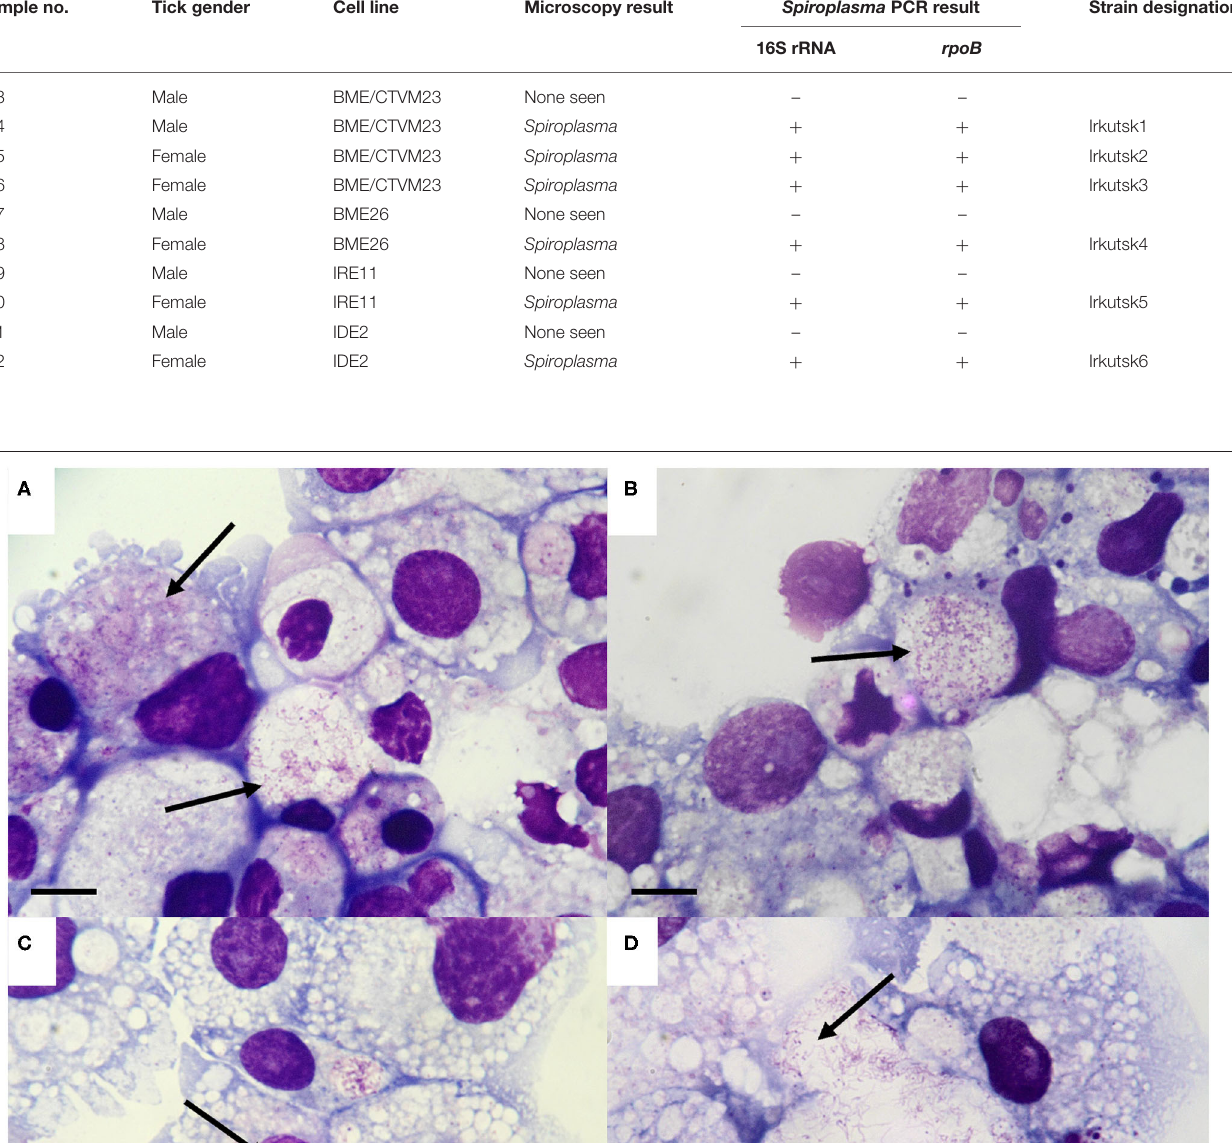
Frontiers in Veterinary Science |